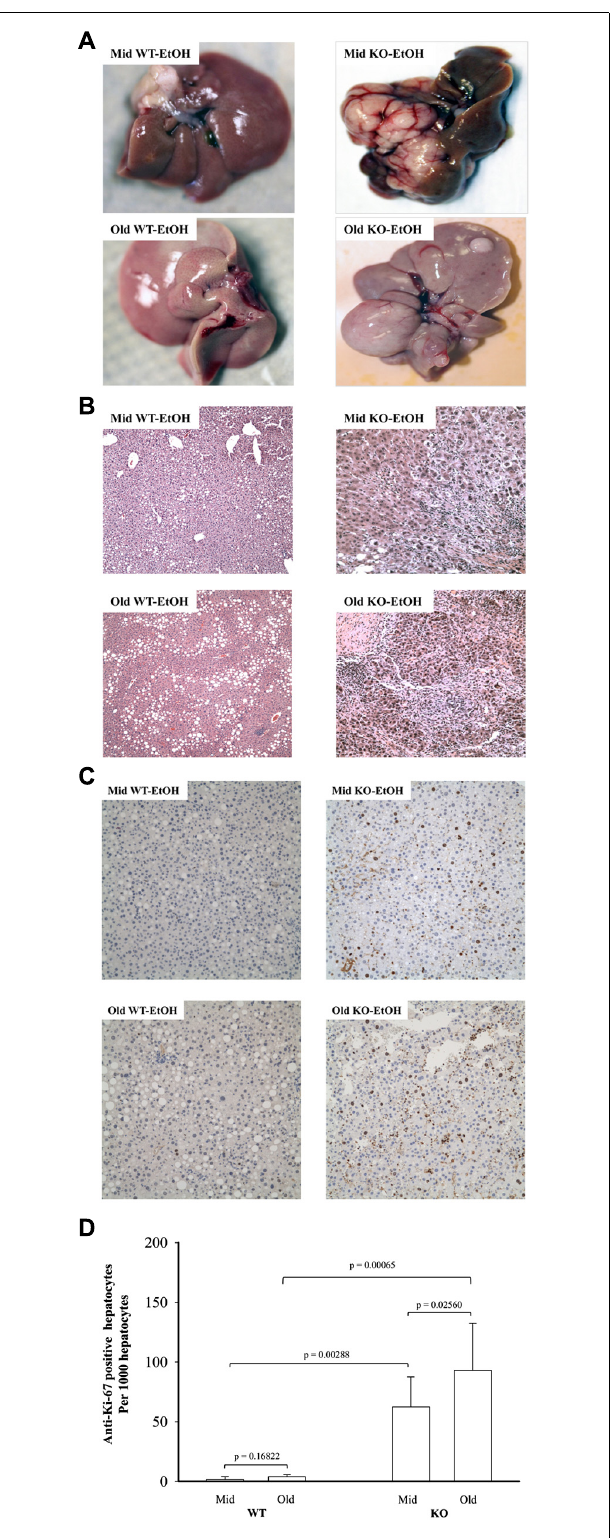
FIGURE 2 | Histology of alcohol-induced liver tumors in female mice under endoplasmic reticulum stress. Female mice at age of 6–8